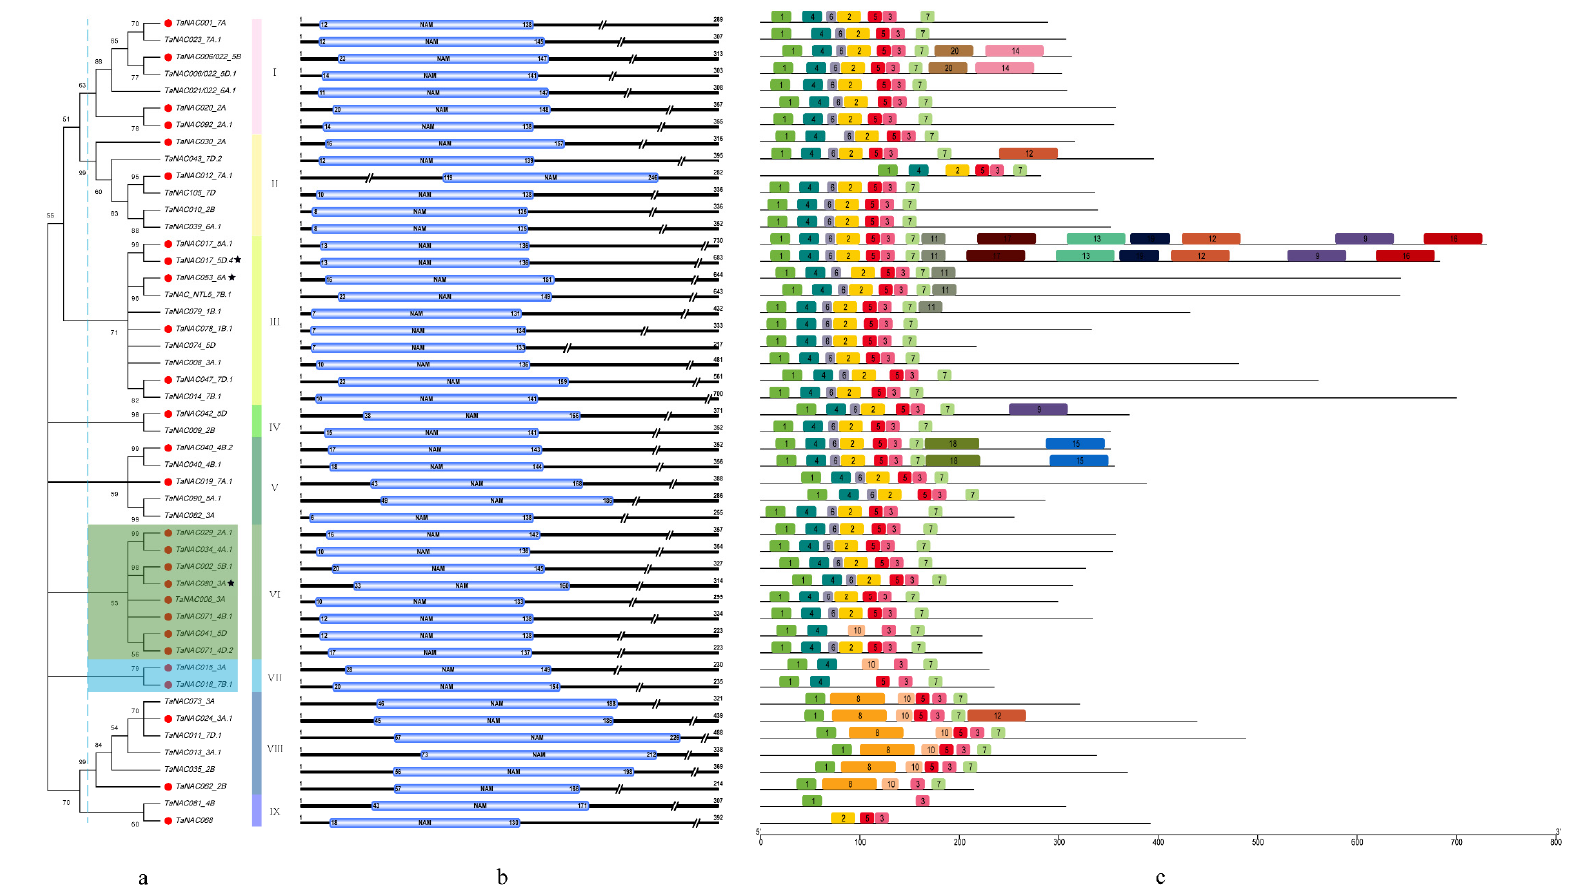
Figure 4. Phylogenetic classification, conserved domain pattern, and conserved motifs of 48 selected TaNAC transcription factors. ( a ) Maximum likelihood (ML) phylogenetic tree. Twenty-seven transcripts with red dots are from DEGs, others from non-DEG. Three transcripts with black pentagons were extracted from IWGSC RefSeq v1.1, and remaining 45 were cloned. ( b ) Domain patterns. For the sake of clarity, each sequence was truncated at di ff erent positions. ( c ) Motif patterns obtained using the Multiple Expectation Maximization for Motif Elicitation (MEME) suite. Sequence logos of Motifs 1–11 (except Motif 9) that had ≥ 5 sites shown in Supplementary Figure